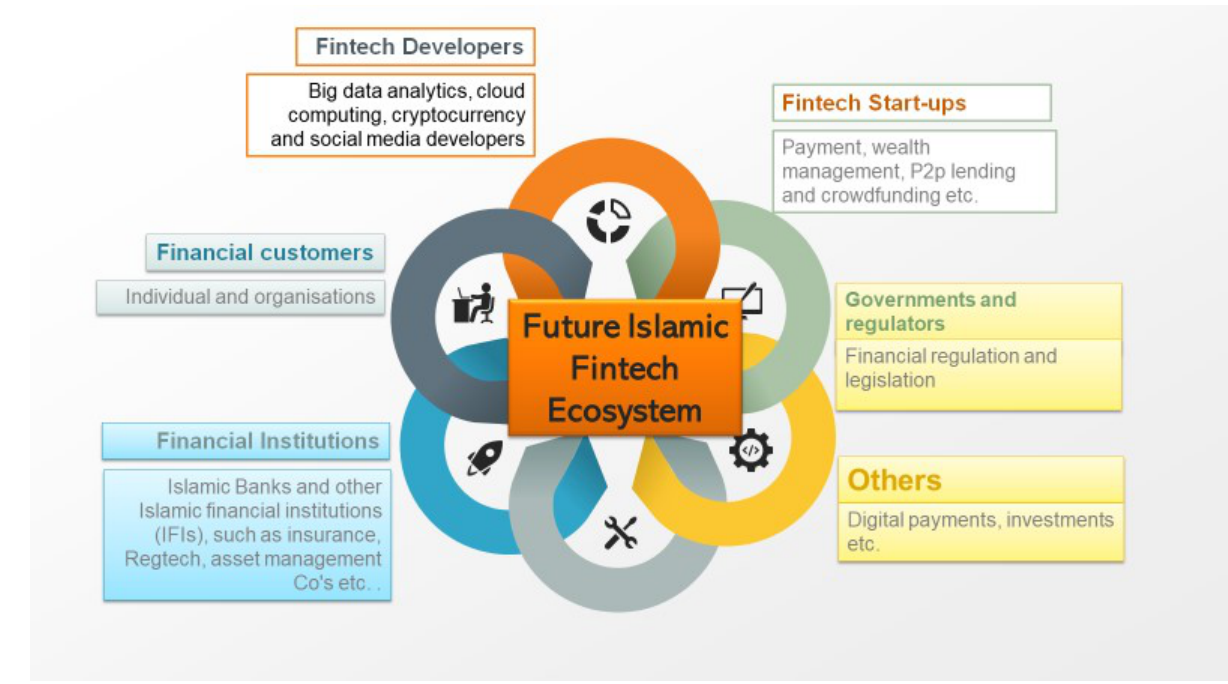
Figure 2. Future Islamic Fintech ecosystem; Source: Author’s own compilation.